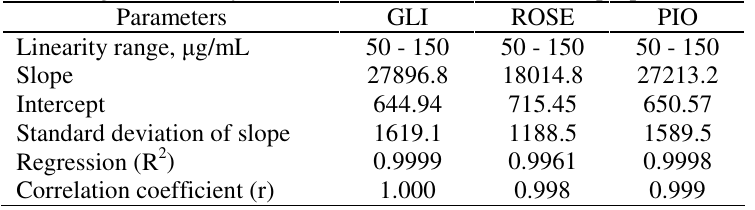
Table 2. Regression analysis of the calibration curves for the proposed